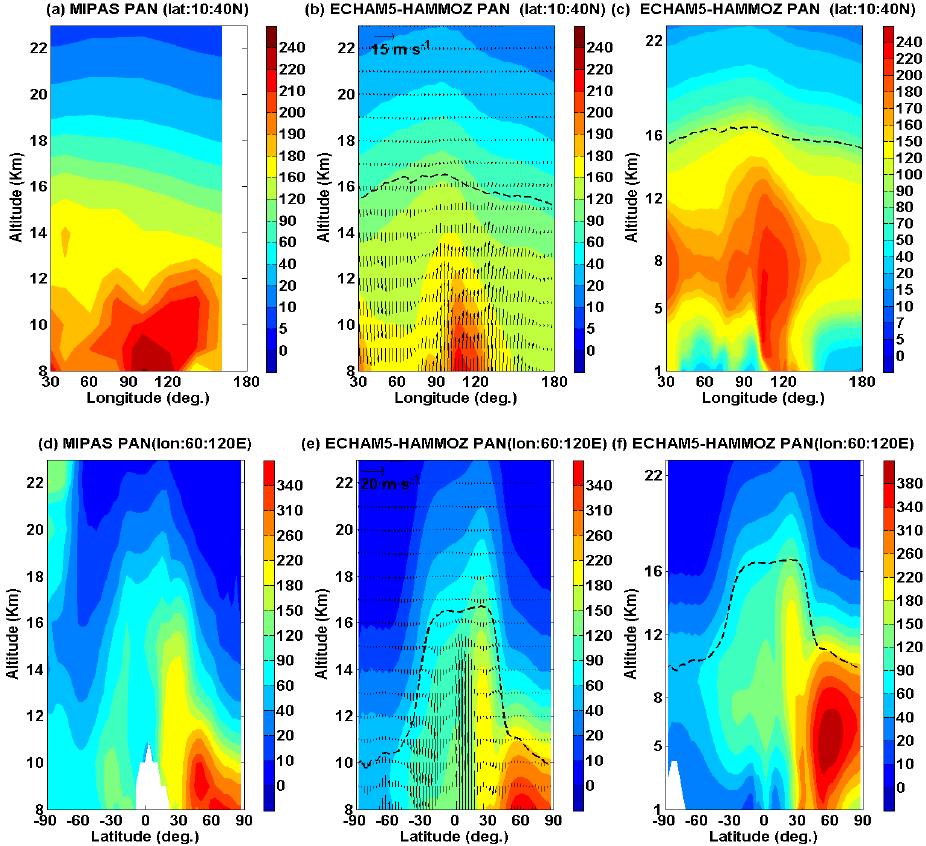
Figure 3. Longitude–altitude cross section of PAN (ppt) averaged for the monsoon season and 10–40 ◦ N: (a) MIPAS (climatology for the Figure 3: Longitude-altitude cross section of PAN (ppt) averaged for the monsoon season period 2002–2011) and (b) ECHAM5-HAMMOZ reference simulation between 8 and 23km. The black arrows indicate wind vectors. The and 10-40 O N (a) MIPAS (climatology for the period 2002-2011) (b) ECHAM5- vertical velocity field has been scaled by 300. Panel (c) is the same as figure (b) but from the surface. Latitude–altitude cross section of PAN (ppt) averaged for the monsoon season and 60–120 ◦ E for (d) MIPAS climatology and (e) ECHAM5-HAMMOZ reference simulation HAMMOZ reference simulation between 8-23km. The black arrows indicate wind between 8 and 23km; (f) same as (e) but from the surface. ECHAM5-HAMMOZ simulation is smoothed with averaging kernels of vectors. The vertical velocity field has been scaled by 300. (c) same as figure (b) but from the surface. Latitude- altitude cross section of PAN (ppt) averaged for the monsoon season and 60-120 O E (d) MIPAS climatology (e) ECHAM5-HAMMOZ reference simulation between8-23km, (f) same as figure (e) but from the surface. ECHAM5- HAMMOZ simulation is smoothed with averaging kernel of MIPAS.